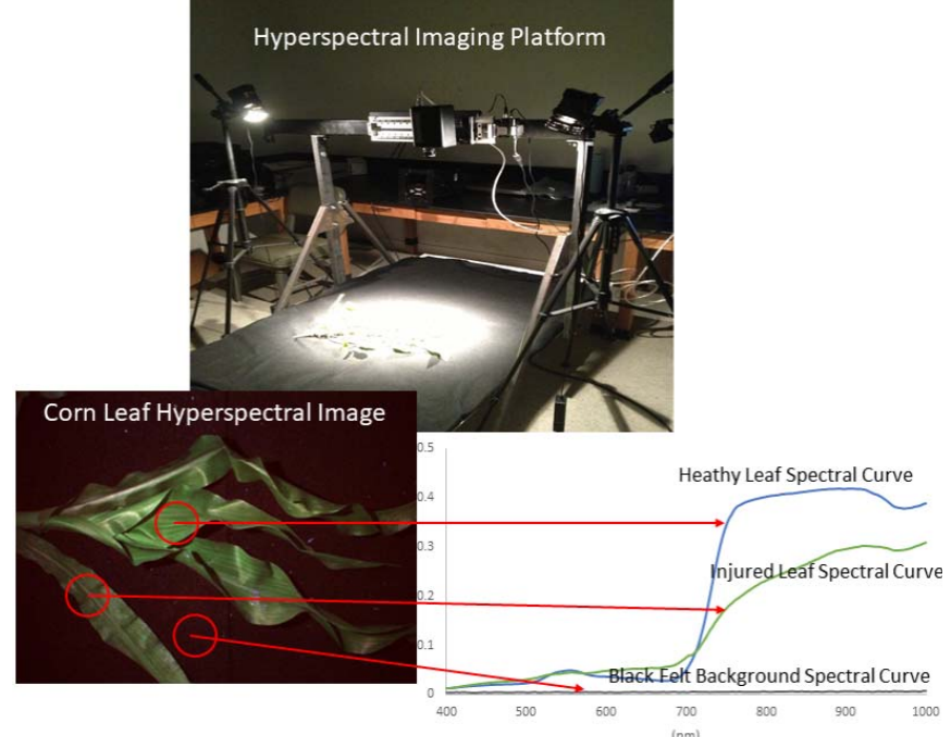
Figure 2. Pika II Visible+Near-Infrared (VNIR) hyperspectral imaging platform for corn leaf